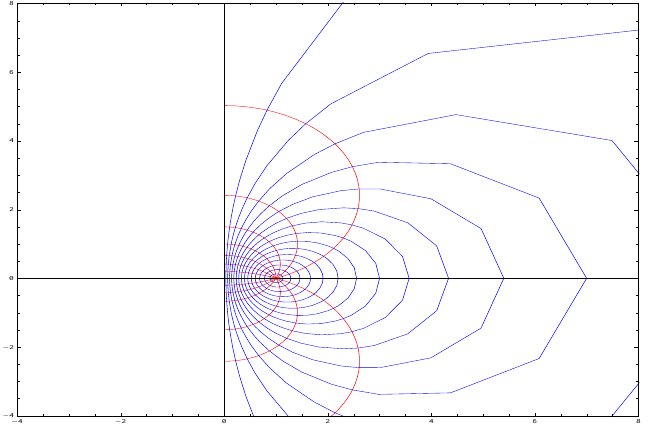
Figure 3. Mapping of the unit disc under Λ